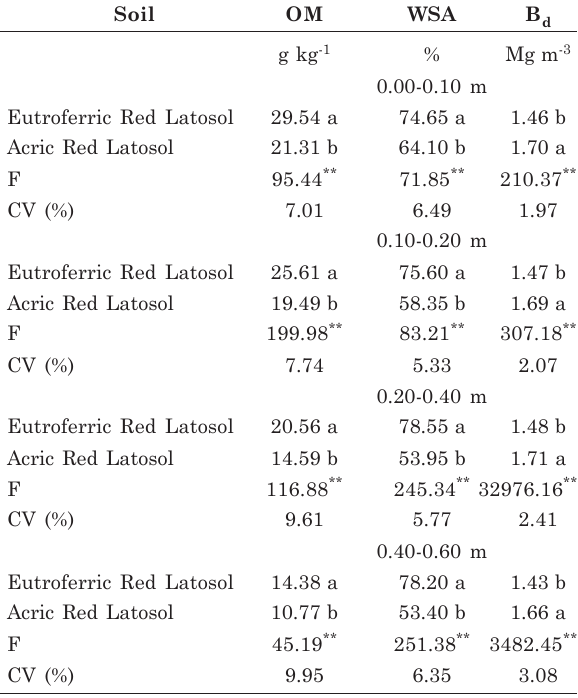
Table 5. Organic matter (OM), water stability of aggregates (WSA) and bulk density (B d ) of the two soils after the first sugarcane harvest